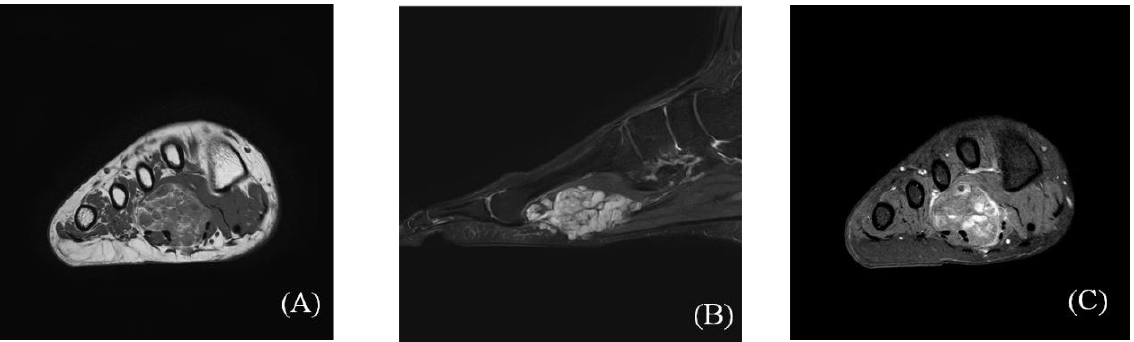
Figure 2. Preoperative magnetic resonance imaging (MRI) scans showing a 5.6 × 2.8 × 2.5 cm multilobulated soft tissue mass in the flexor digitorum brevis muscle, which penetrates the plantar fascia and spreads to the subcutaneous layer. ( A ) Axial T1-weighted images; ( B ) sagittal T2-weighted images; ( C ) axial gadolinium T1-weighted image.